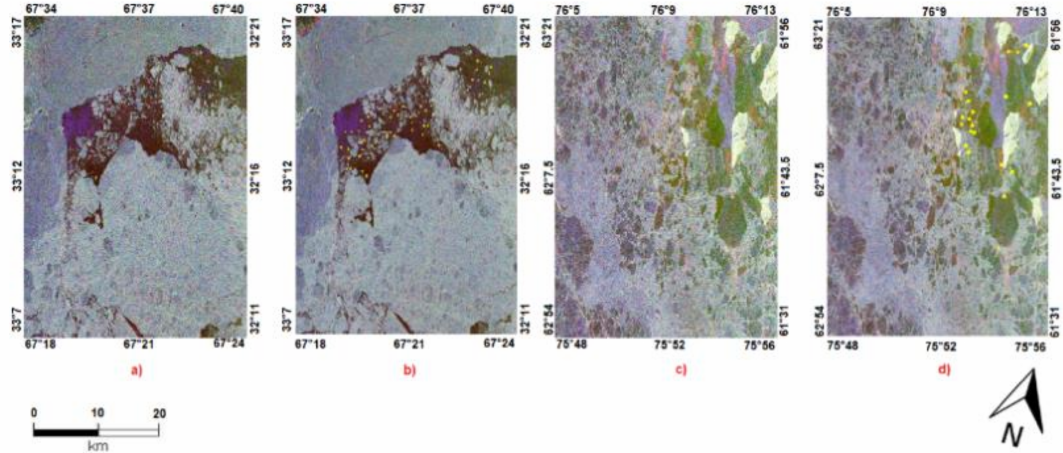
Figure 5. Output images for ( a ) Blosseville Coast S Pauli RGB image 20 June 2015 01:26, ( b ) Blosseville Coast S visual analysis, ( c ) Savissivik RGB image 6 December 2017 02:52, and ( d ) Savissivik visual analysis. Yellow dots are icebergs. Note that Blosseville Coast S is not used in this paper. Reprinted with permission from ref. [22] Copyright 2020 Remote